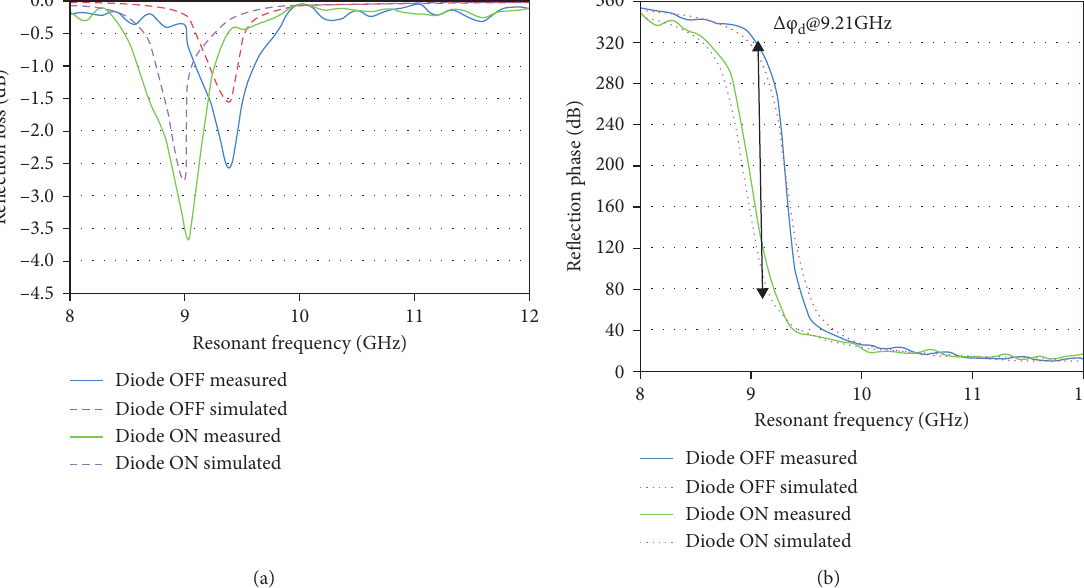
Figure 1: Reflectarray unit cell. (a) Proposed design configuration. (b) Fabricated unit cell, biasing circuit, and complete measurements setup. 0.0